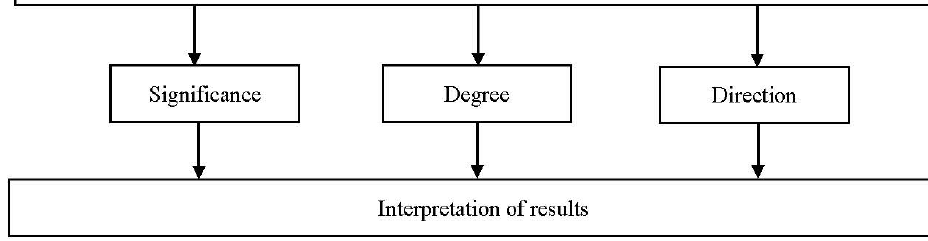
Figure 2. Research Figure 2. Research design.